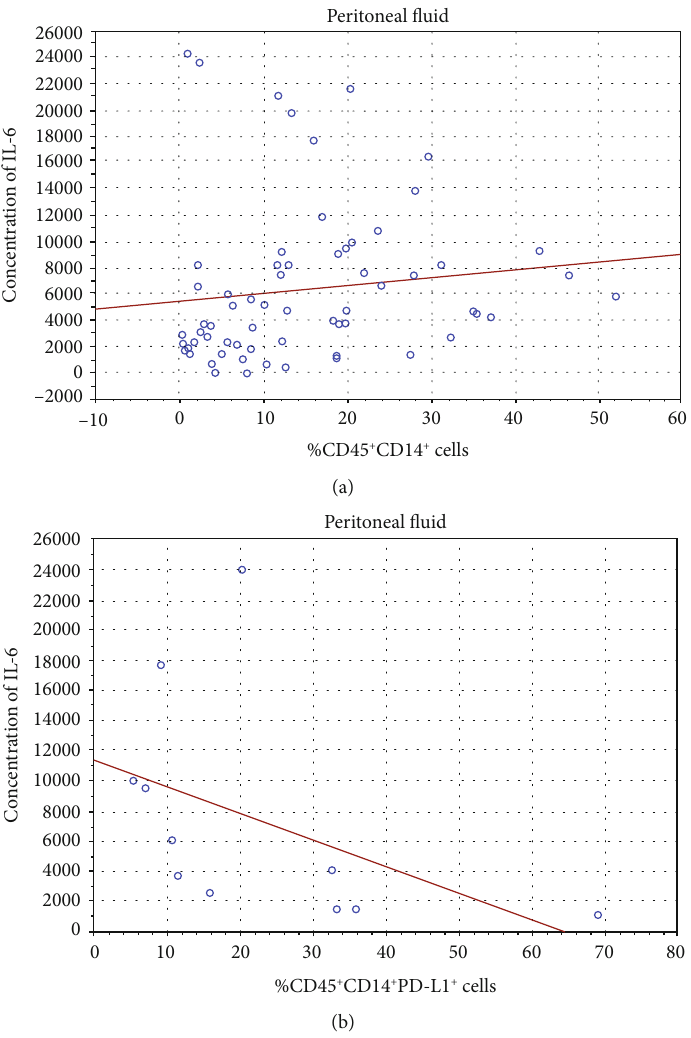
Figure 6: Relationship between the IL-6 levels and the percentage of (a) CD45 + CD14 + and (b) CD45 + CD14 + PD-L1 + cells in PF of OC